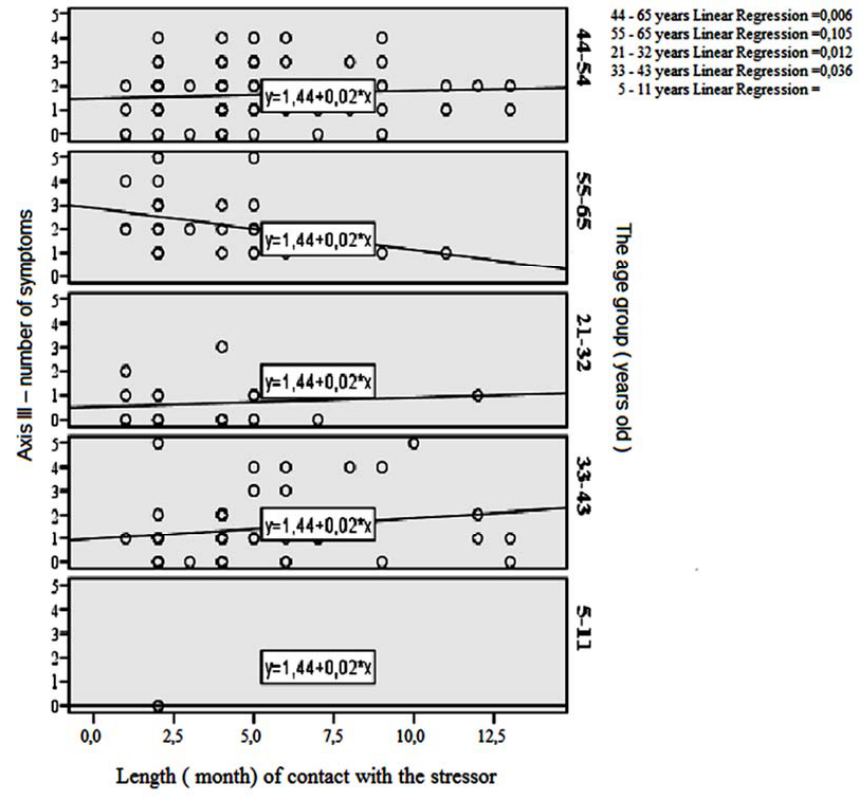
Figure 1. Length of contact with the stressor in the scatter plot.